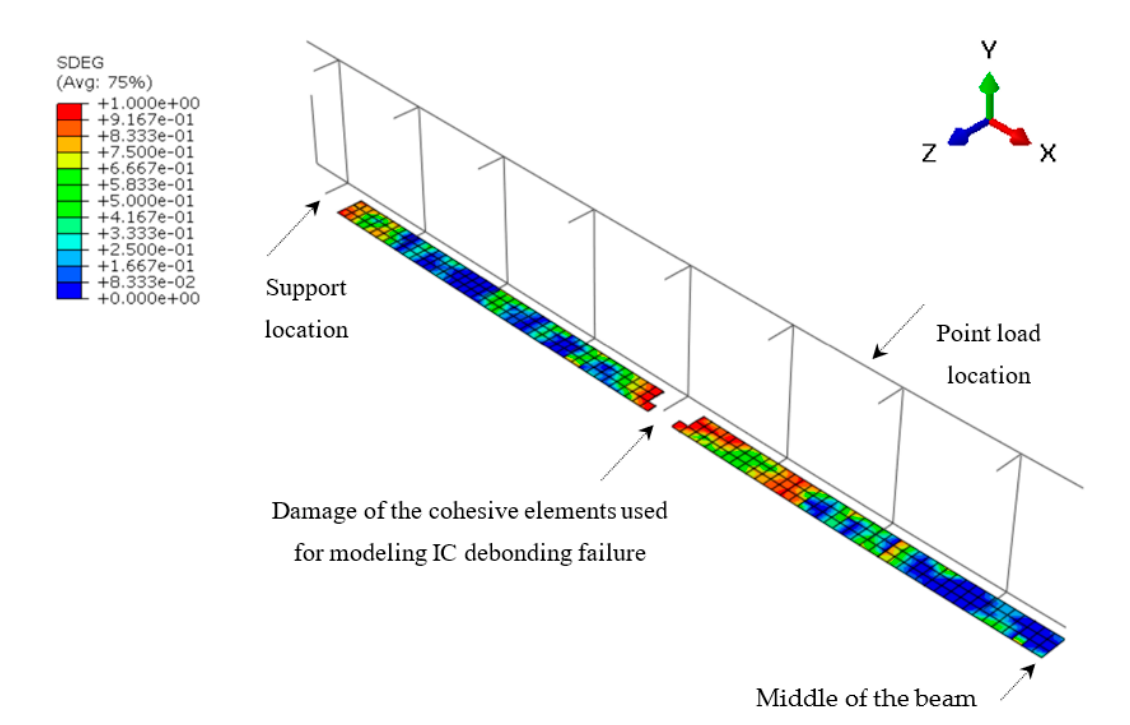
Figure 17. Failure of the beam S-5.0/S-300 used in the parametric study.